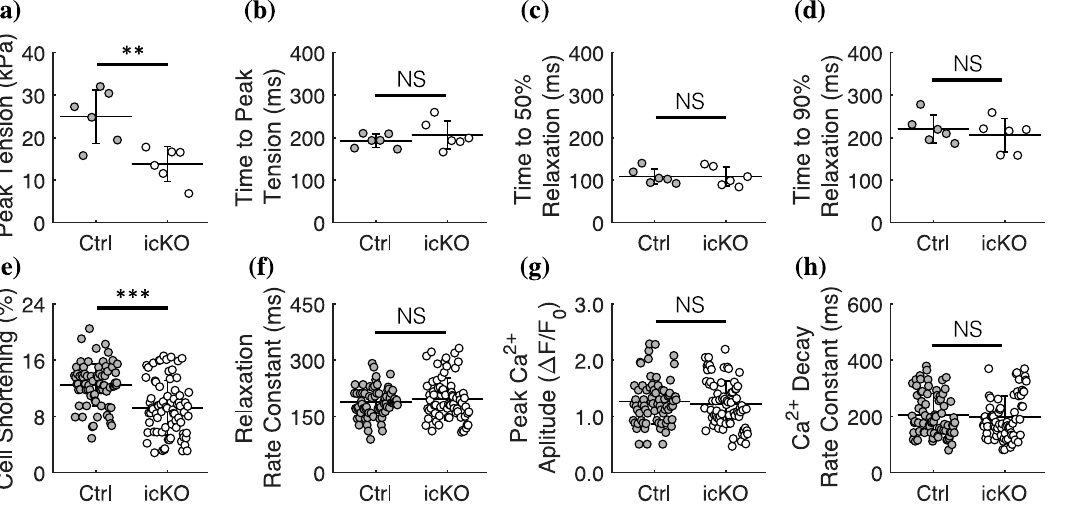
Figure 1. FLNC deletion in adult mouse hearts reduces cardiomyocyte contractility without affecting Ca 2+ signaling. Peak twitch tension ( a ) in intact papillary muscles from icKO hearts was significantly reduced compared with controls. Time to peak twitch tension ( b ) and time to 50% ( c ) and 90% ( d ) relaxation (RT50 and RT90, respectively) were not different in papillary muscles from icKO vs. control hearts. Similar to the intact papillary muscles, intact single cells isolated from icKO hearts exhibit significantly reduced cell shortening ( e ) compared with cells from control hearts, while the relaxation rate constant ( f ) was not different between groups. The peak amplitude of the calcium transient ( g ) and cytosolic calcium decay rate constant ( h ) was not different between groups. ** p < 0.005, *** p < 0.0005, and NS = Not Significant for unpaired student’s t -test between groups. N = n = 6 for intact papillary muscles from each group, and n > 70 for isolated cells from each group from N = 6 animals in each group.